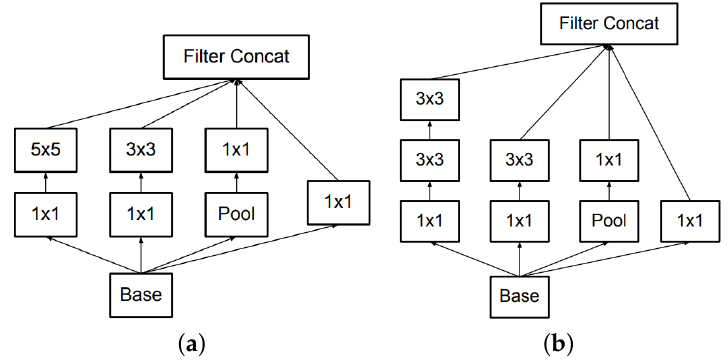
Figure 3. ( a ) Inception module of GoogLeNet; ( b ) Inception-v2